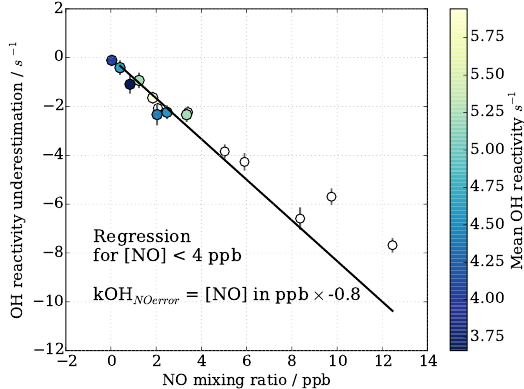
Figure 12. OH reactivity underestimation for MOHp relevant NO mixing ratio and typical OH reactivity (maximum 15s − 1 ) . Filled circles are data used for linear regression to obtain mean underesti- mation of OH reactivity for NO up to